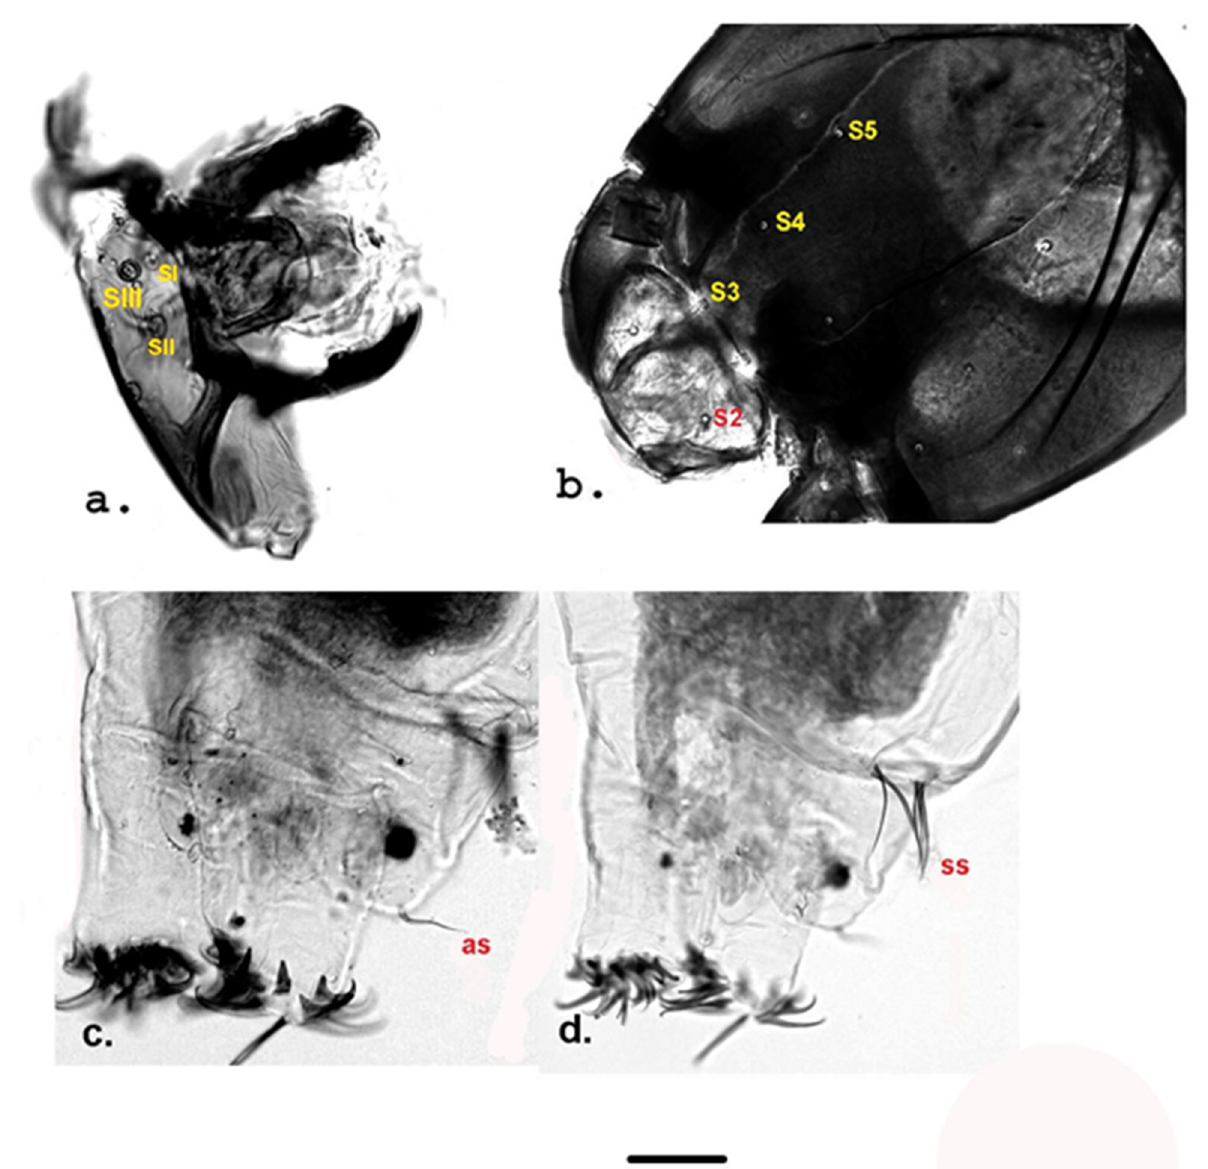
Figure 3. Larval morphology of Belgica antarctica (Jougla Point). ( a ) Antenna—blade (bl); Ring Organ (RO); Lauterborn—organ (LO); ( b ) Ungula (U); premandibles (prem.) and basal sclerite (BS); ( c ) Pre- mandible (prem.); ( d ) Pecten epipharyngis (p.e.) and posterior seta (SII) + larger peg of bisensillum (SIV), S1 and S2 of the clypeus; Scale bar 10 µm.